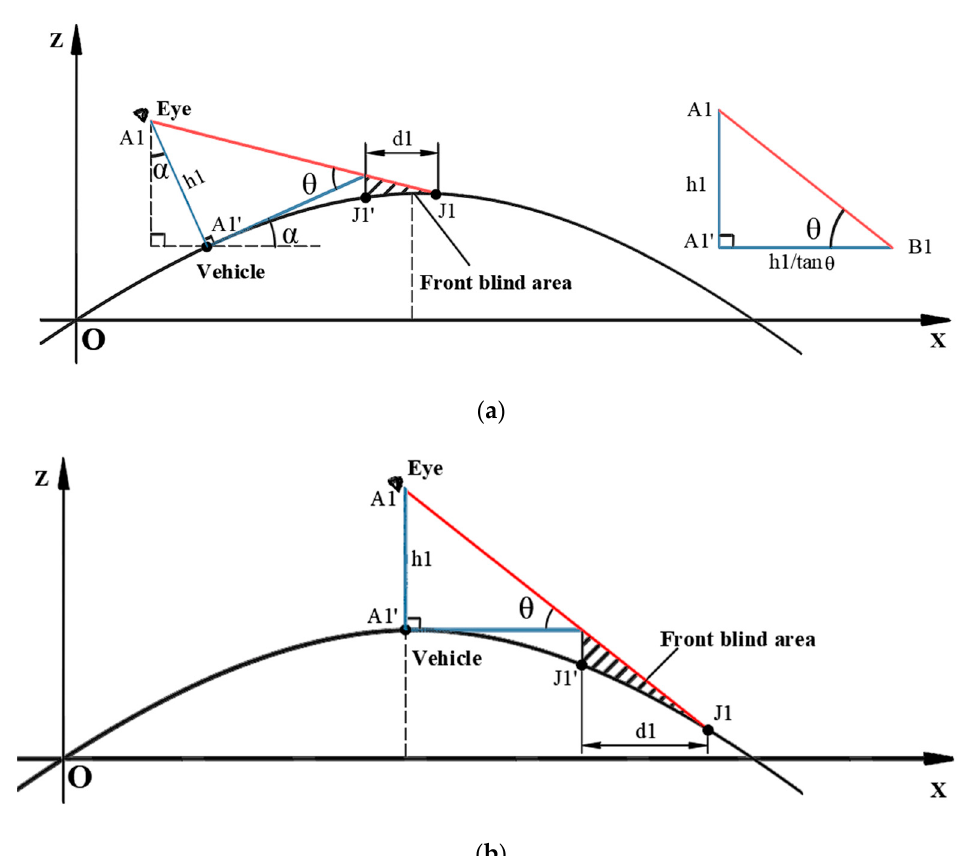
Figure 7. Diagram of front blind area’s calculation. The vertical blue line A1A1 ′ represents the eye height; the red line A1J1 represents the tangent line between the eyes and the front cover of the car; the black curve represents the current configuration of the main beam; the intersection of the sightline and the configuration is J1; the shaded part represents the front blind area for the driver’s vision; d1 represents the length of the front blind area. ( a ) At time t, when the vehicle drives towards the wave peak, the driver’s visual front blind area is calculated. The triangle at the right of figure is a simplified vehicle model. h1 represents the eye height. θ is the angle between the driver’s sightline which is tangent to the front cover of the car and the horizon. A1 represents the position of the eye. ( b ) At time t + n, the driver’s visual front blind area is calculated when the vehicle is at the wave’s